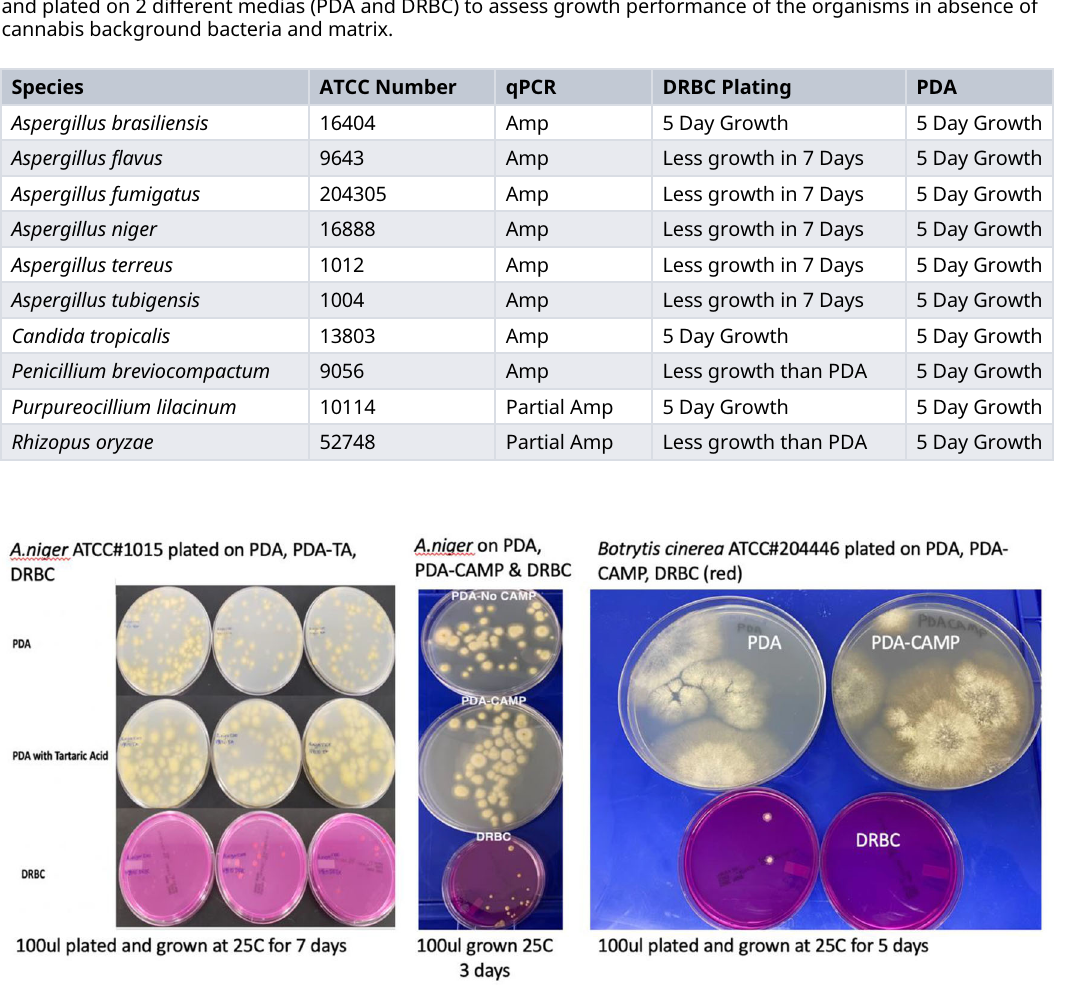
Figure 7. Aspergillus niger and Botrytis cinerea monocultures plated on3 different medias. Cultures were plated on Potato Dextrose Agar (PDA), PDA with selection (chloramphenicol or Tartaric acid), and Dichloran Rose Bengal (DRBC). Fewer colonies are consistently found on